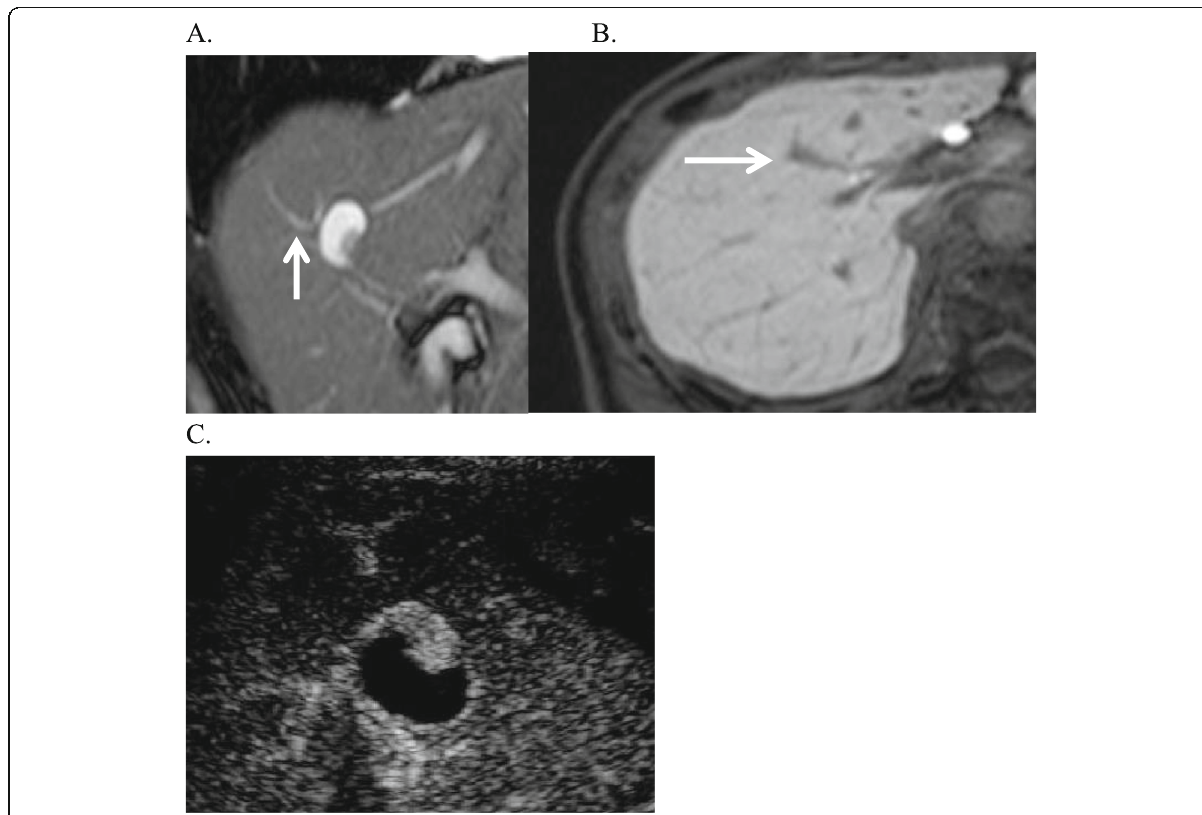
Fig. 2 a , b Magnetic resonance imaging findings. c Ultrasonography findings. Magnetic resonance imaging showed slight dilation of the distal bile duct (white arrow). Ultrasound showed a highly echoic papillary nodular area in the cystic